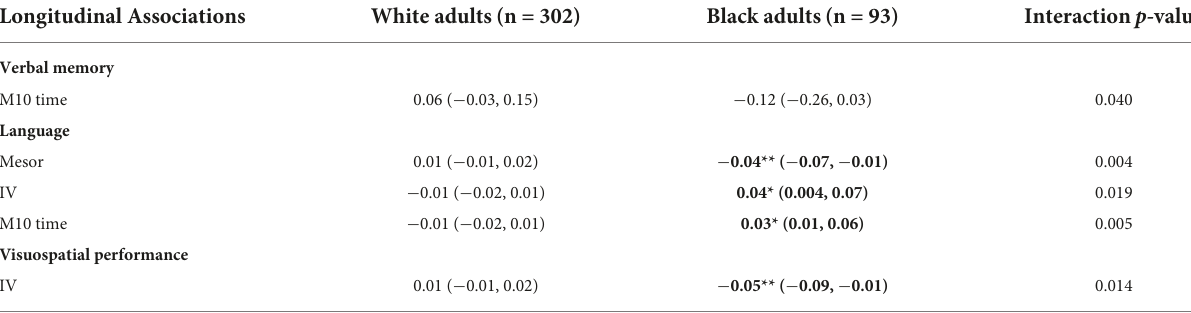
TABLE 13 Race: significant longitudinal interactions with CRARs on cognition, estimated beta (95% CI). Longitudinal Associations White adults (n = 302) Black adults (n = 93)